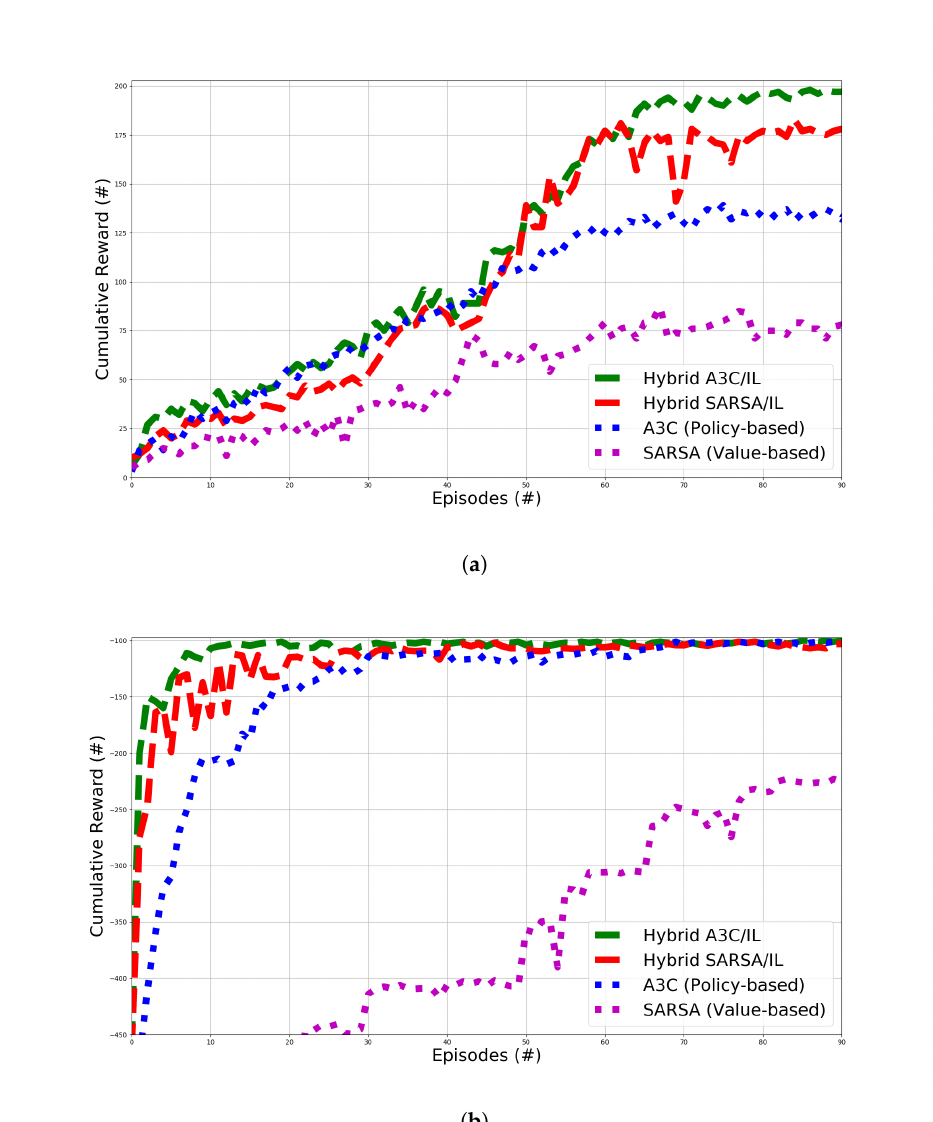
Figure 4. Experimental results: ( a ) Continuous classic cart-pole OpenAI-Gym environment, ( b ) continuous classic mountain-car OpenAI-Gym